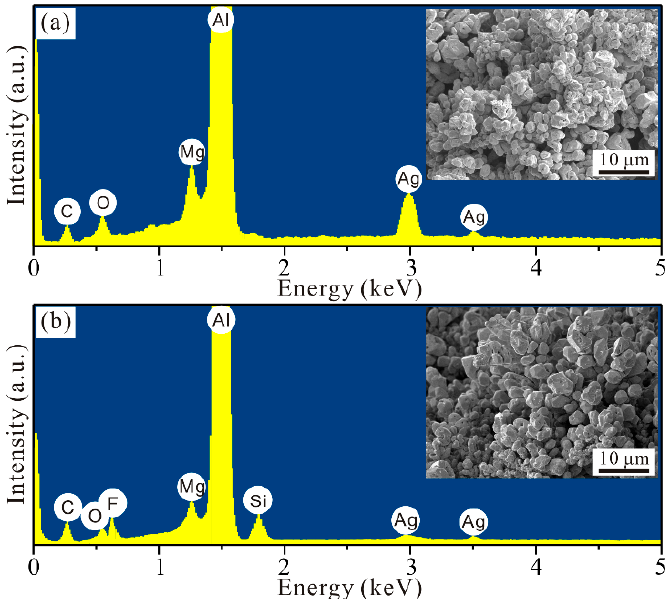
Figure 5. Energy Dispersive X-ray Spectrometer (EDX) spectra and SEM images of deposited Al alloys ( a ) before and ( b ) after 1H,1H,2H,2H-Perfluorodecyltrichlorosilane modifier (FAS) modification.